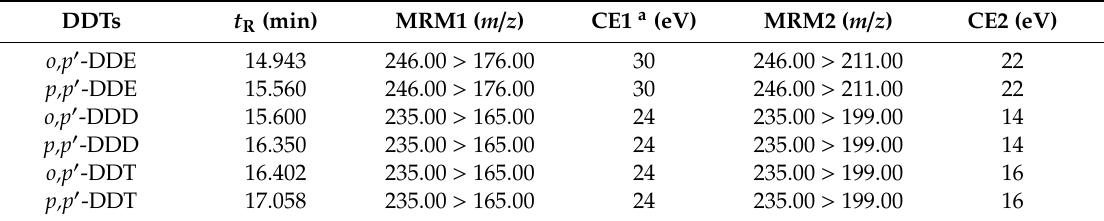
Table 4. Acquisition and chromatographic parameters for